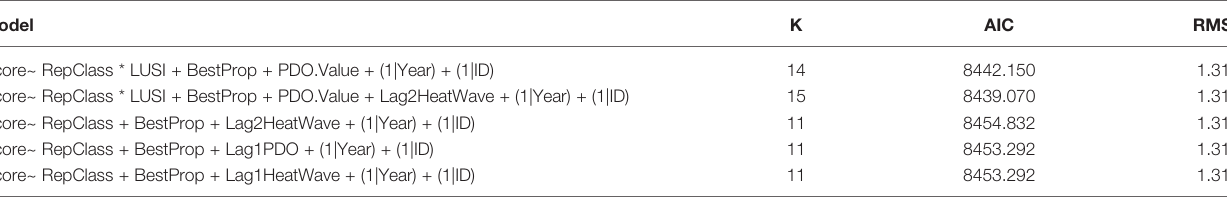
Bodyconditionscore(Score)relativetopredictorvariablesreproductiveclass(RepClass),theproportionofimageseen(BestProp),PDOvalue,LUSI,presenceofaheatwave(HeatWave), and PDO being positive or negative (PDO). Lag models have a one-or two-year lag of environmental predictor variables. Since the best two models with a 1-year lag had the same AIC score they were both included in the fi nal model analysis. The most parsimonious model is shown in bold. K, number of parameters; AIC (Akaike Information Criterion), relative model fi t; RMSE (Root Mean Square Error), standard deviation of the